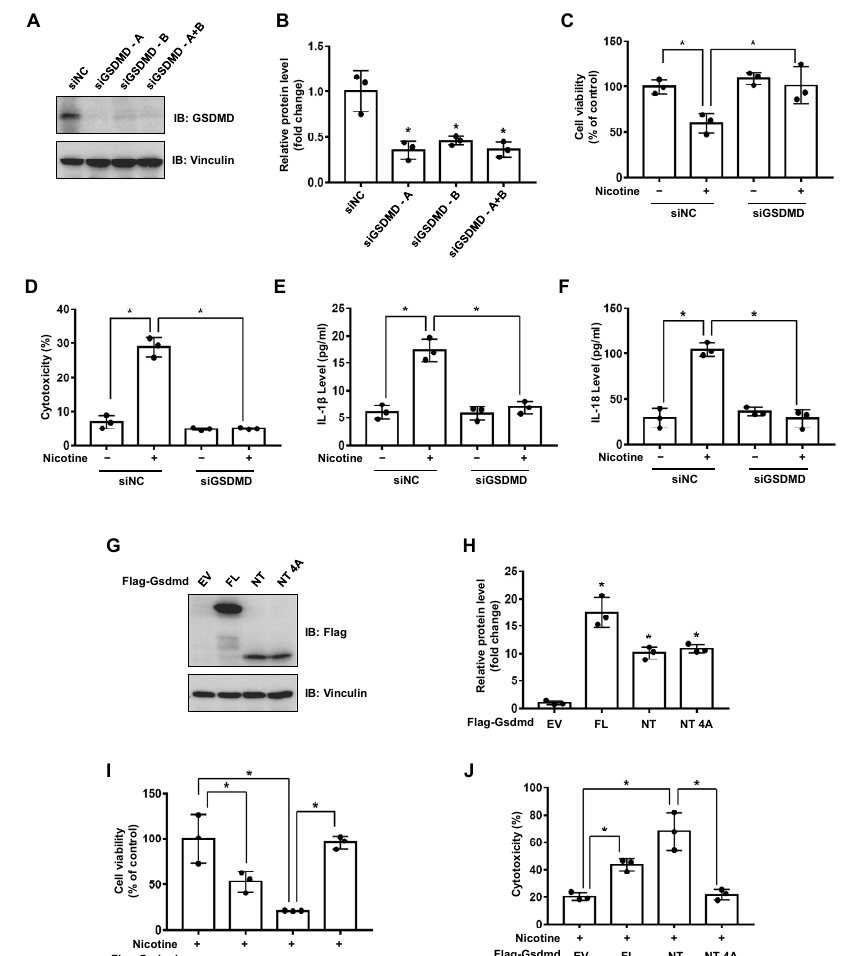
Figure 2. Nicotine induces pyroptosis through the cleavage of GSDMD. ( A ) LO2 cells were transfected with the indicated siRNA for 36 h, the protein levels of GSDMD were determined by using Western blotting. ( B ) Quantification of GSDMD protein level as in ( A ). ( C – F ) LO2 cells were transfected with the indicated siRNA for 24 h followed by the treatment with 100 µ M nicotine for 24 h. Cell viability was determined by CCK-8 assay following exposure to nicotine ( C ). Cytotoxicity was determined by LDH release assay following exposure to nicotine ( D ). The concentrations of IL-1 β ( E ) and IL-18 ( F ) in the conditioned medium were determined by ELISA. ( G ) Western blotting of cell lysates derived from LO2 cells transfected with the indicated plasmids for 36 h. ( H ) Quantification of protein levels as in ( G ). ( I , J ) LO2 cells transfected with the indicated plasmids for 24 h followed by the incubation with 100 µ M nicotine for 24 h. Cell viability was detected by CCK-8 assay following exposure to nicotine ( I ). Cytotoxicity was determined by LDH release assay following exposure to nicotine ( J ). n = 3, data shown represent the mean ± SD (*, p <